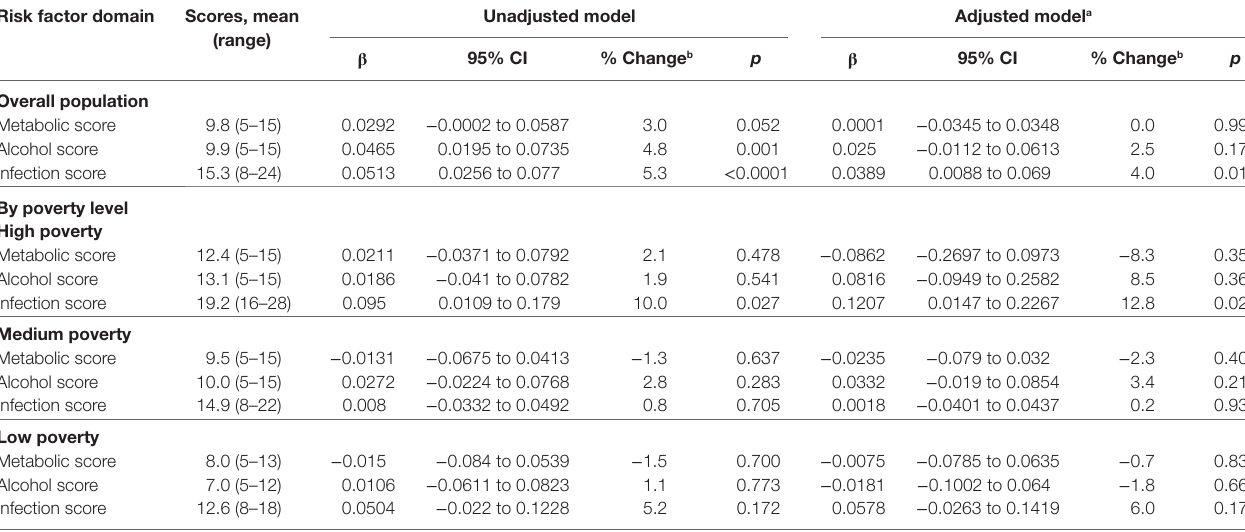
TaBle 3 | Association between liver cancer incidence and risk factor scores.